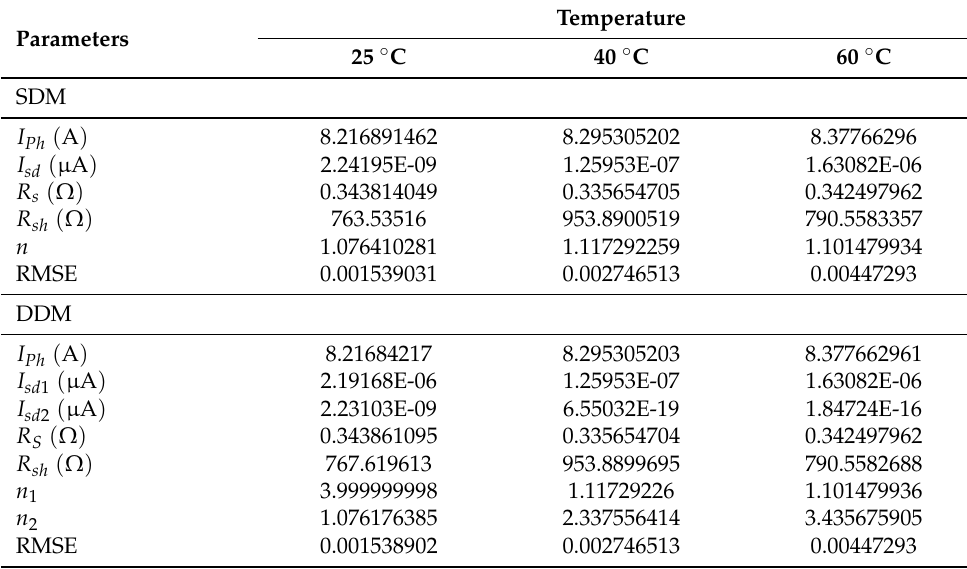
Table 18. Optimal parameters with various temperatures under 1000 irradiance on